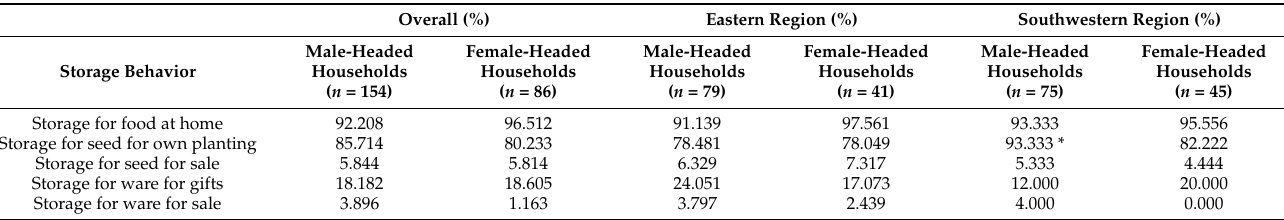
Table 4. Purpose of potato storage by farmers.